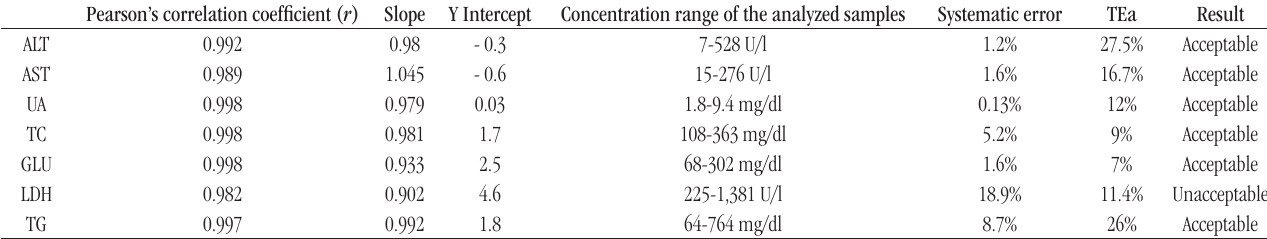
taBLE − Results of the comparative statistical analysis of data obtained by instruments Labmax 240 ® (E1) and Labmax 240 Premium ® (E2); n = 40, linear regression analysis¹ obtained by EP Evaluator ® software